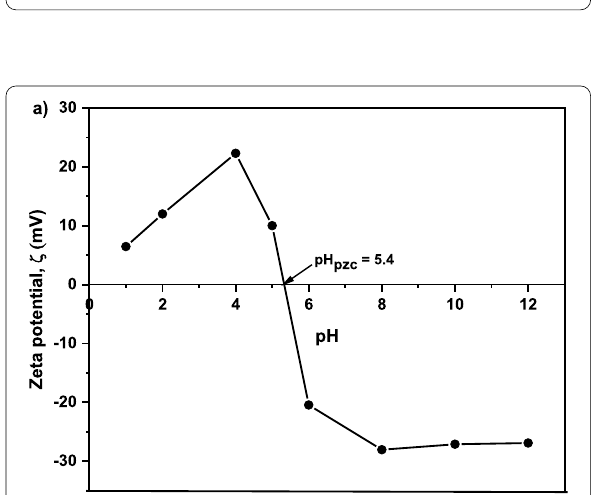
Fig. 8 The Fourier transform infrared spectra of MNA-7 h before and after adsorption of Cu (II) ion